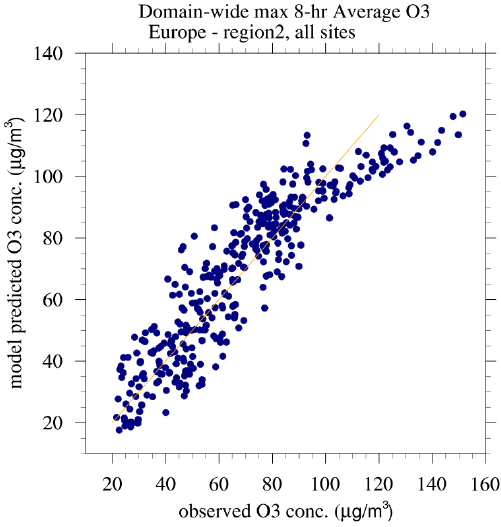
Figure 8. Scatter plot of maximum 8h running average ozone con- centration in northern Europe.